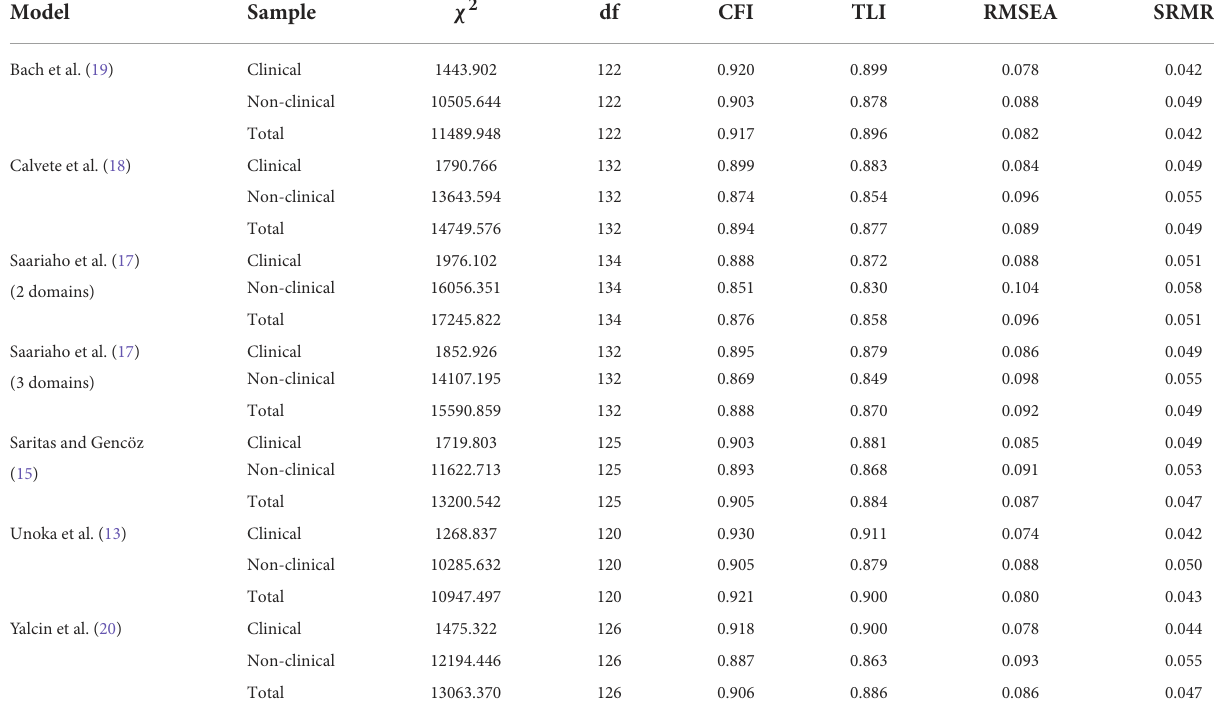
TABLE 4 Results of CFAs of different proposed